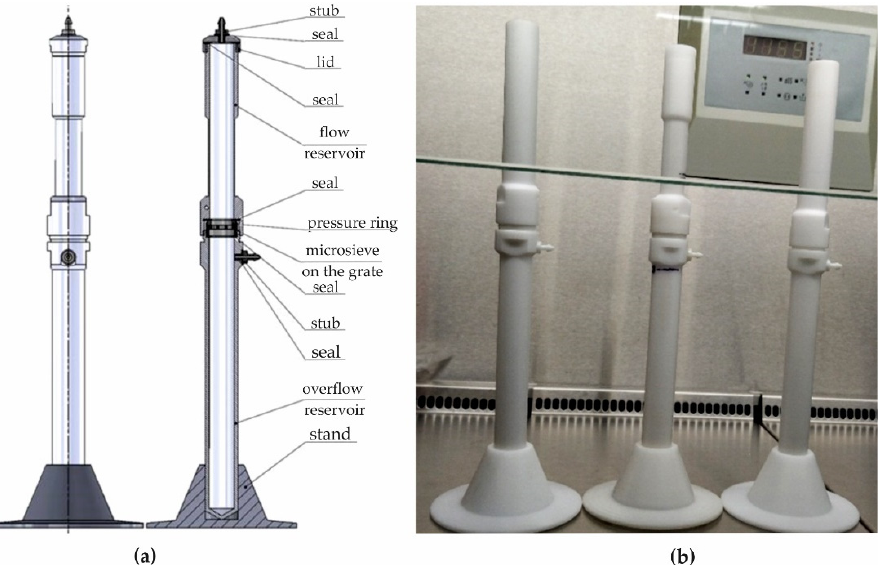
Figure 8. Scheme ( a ) and photo ( b ) of the screening column . Cell separation of the cancer cells was performed under sterile conditions. All ele- an autoclave Tuttnauer EL-D (Tuttnauer, 25 Power Dr, Hauppauge, NY 11788, USA).